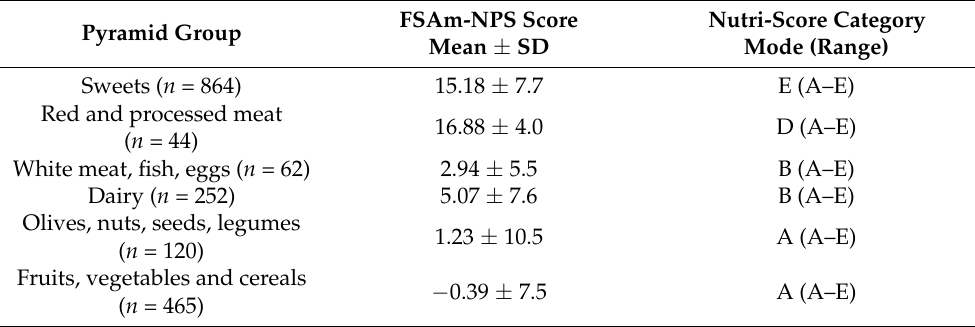
Table 3. FSAm-NPS Score and Nutri-Score category across the sustainable Mediterranean diet tiers